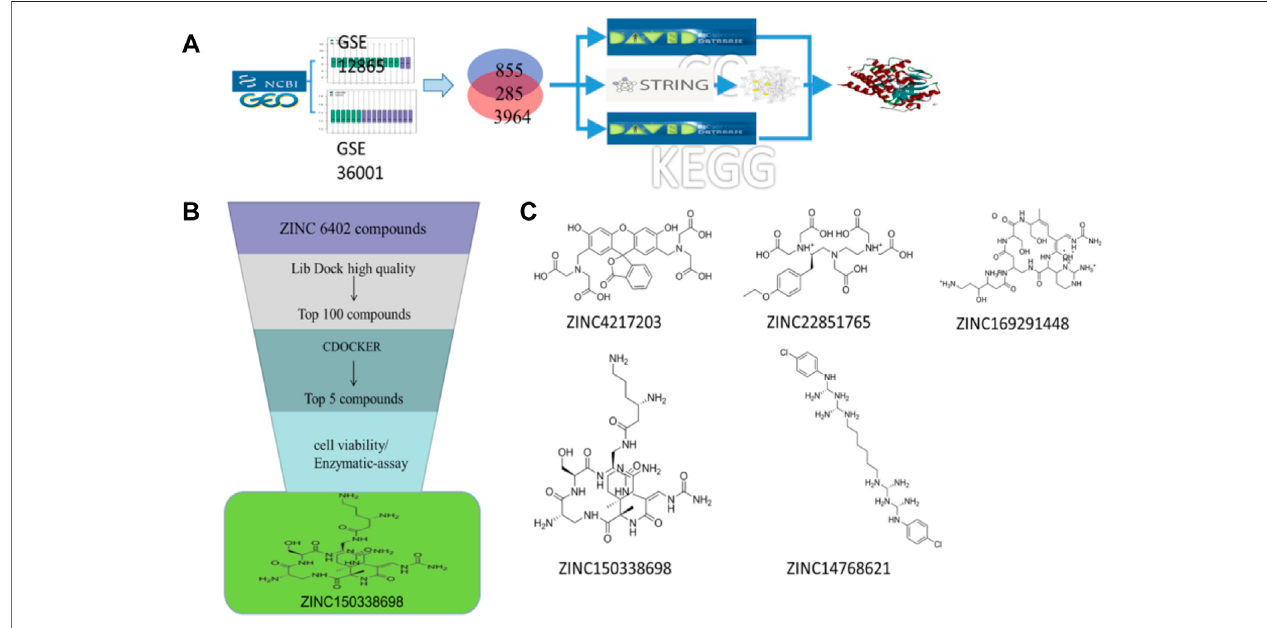
FIGURE 1 | (A) Schematic diagram of screening key genes; (B) virtual docking process; (C) top fi ve compounds in virtual screening